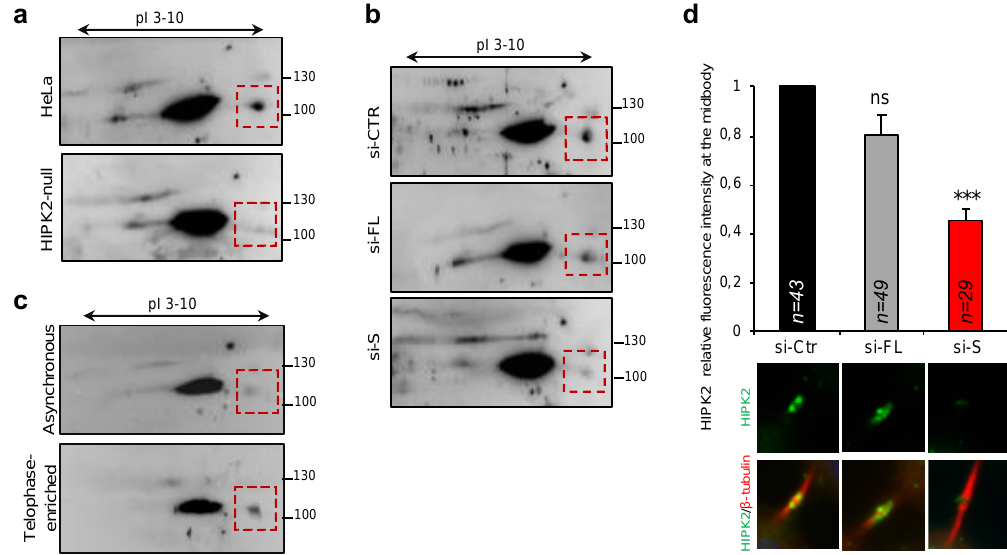
Figure 7. ( a , b ) HeLa cells and their indicated derivatives were lysed and total cell extracts separated onto parallel 2D SDS-PAGE. The HeLa derivative are: (i) HIPK2-null, obtained by CRISPR / Cas9; (ii) si-CTR, parental HeLa cells transfected with the universal negative siRNA control; (iii) si-FL, parental HeLa cells transfected with si-FL1 / si-FL2 siRNAs; and (iv) si-S, parental HeLa cells transfected with si-S1 / si-S2 siRNAs. WB were performed with anti-HIPK2 rabbit polyclonal Ab by L.M. Schmitz. Red square boxes highlight the HIPK2-S isoform. ( c ) Parental HeLa cells were maintained in proliferating, asynchronous condition or synchronized and enriched in telophase and analyzed as in ( a , b ). ( d ) Parental HeLa cells were transfected as in Figure 5b and analyzed 96 h post-transfection by IF after staining with anti-HIPK2 (pan-HIPK2, Ab946) in combination with anti- β -tubulin Ab to mark midbody. Data are reported as mean ± standard error of mean (SEM) of three independent experiments *** p < 0.0001. Quantification of IF signals was performed by measuring the mean of pixel intensity at midbody corrected for external background. Representative images are reported below each column.